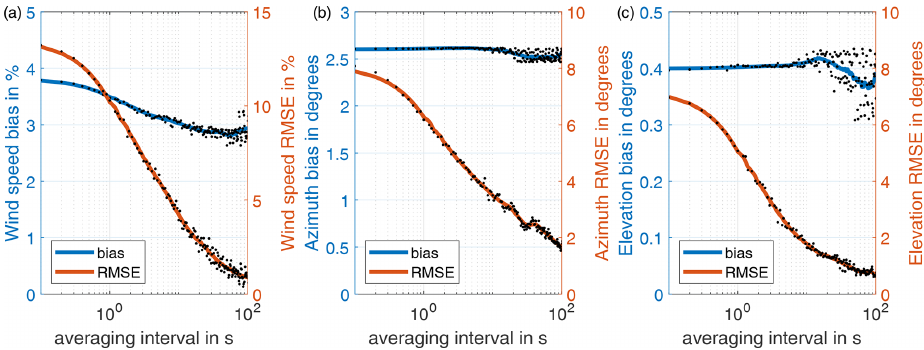
Figure 15. Bias and RMSE of the UAV wind speed (a) , azimuth (b) and elevation (c) measurements at 40m height for averaging intervals between 0.1s (10Hz) and 100s (0.01Hz). The PTB lidar is used as a reference